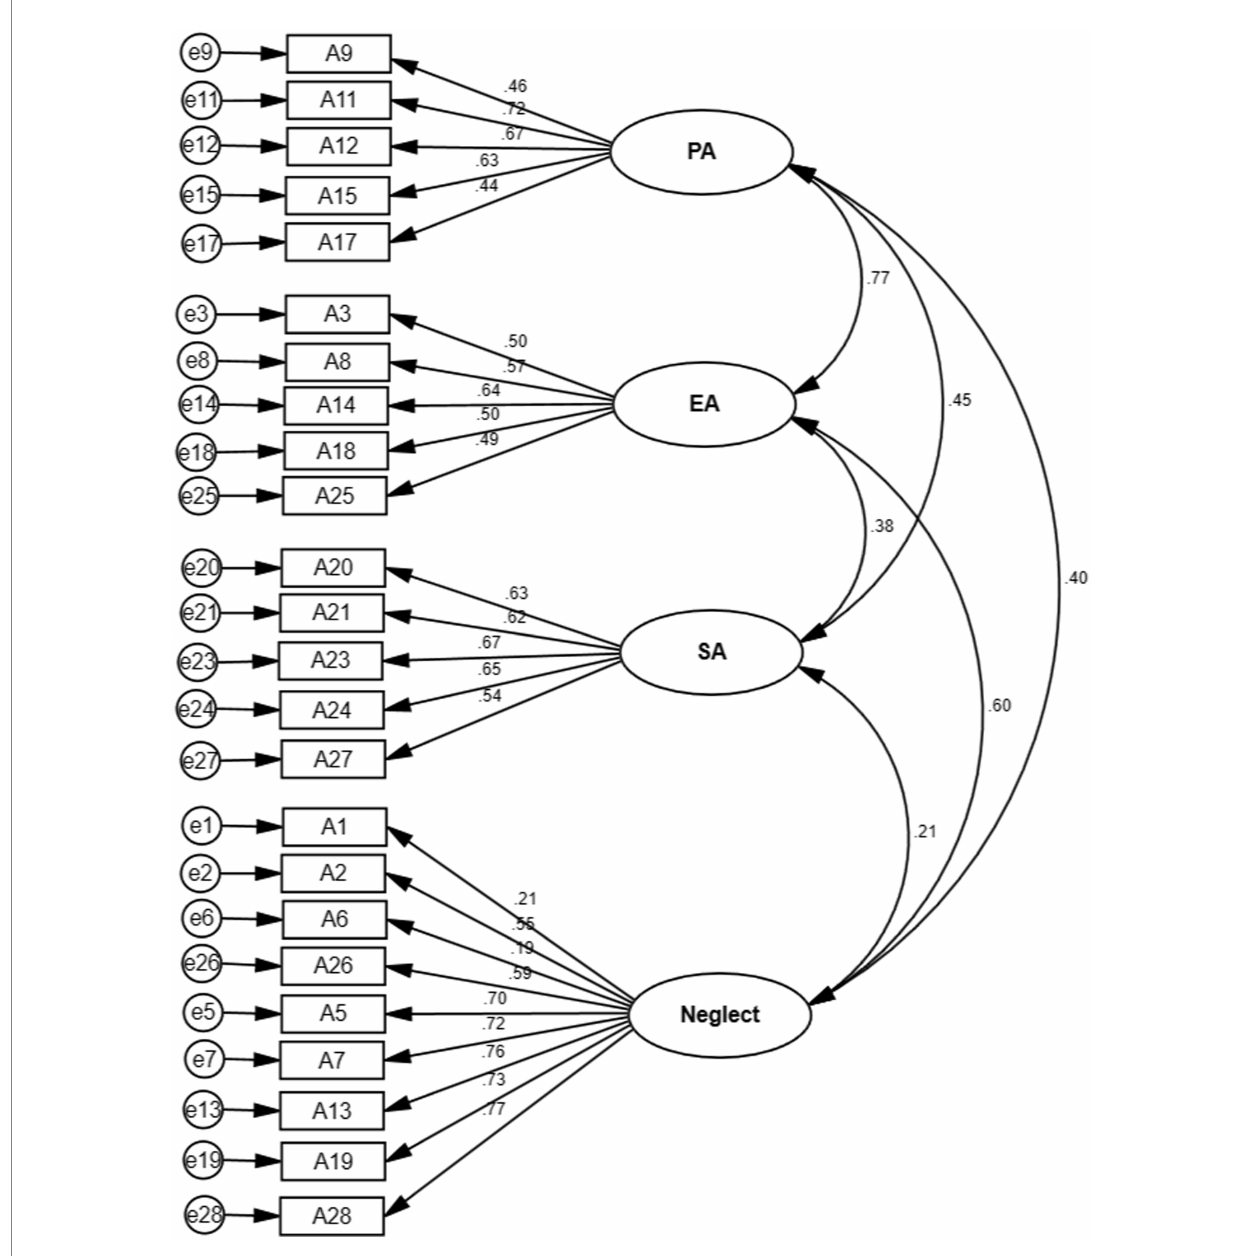
FIGURE 1 CFA path diagram of the alternative CTQ-SF model. PA: Physical Abuse; EA: Emotional Abuse; SA: Sexual